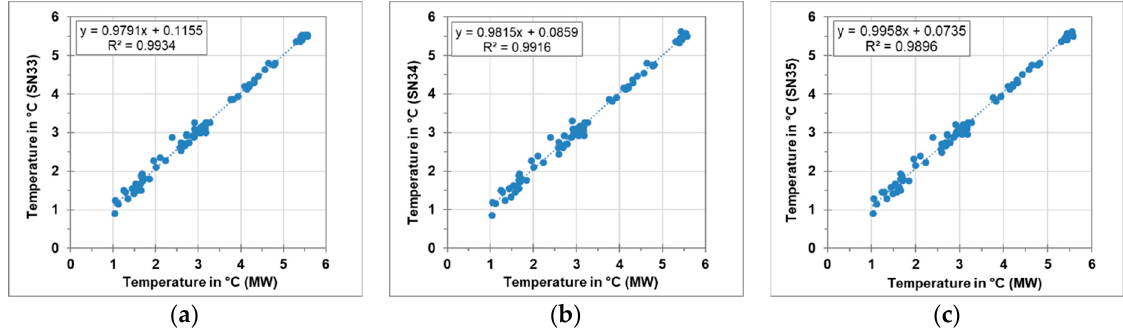
Figure 19. Comparison of temperature sensors at stationary monitoring station and HOBO sensors ( a ) SN33 ( b ) SN34 ( c ) SN35.